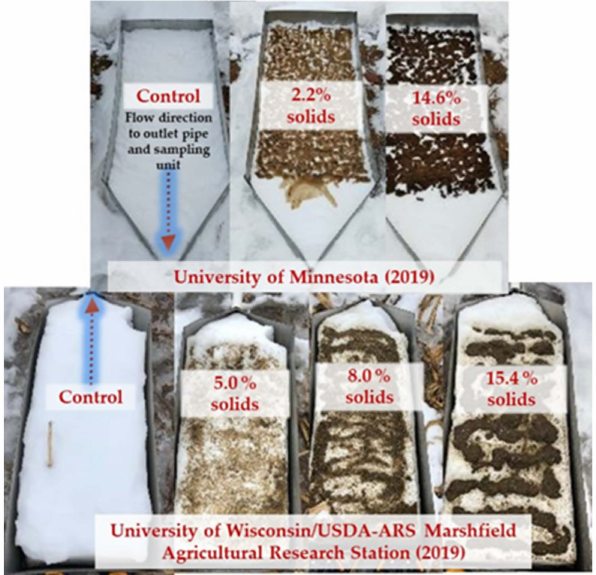
Figure 1. Photographs showing snowmelt runoff plots after manure application for the University of Minnesota and Marshfield Station